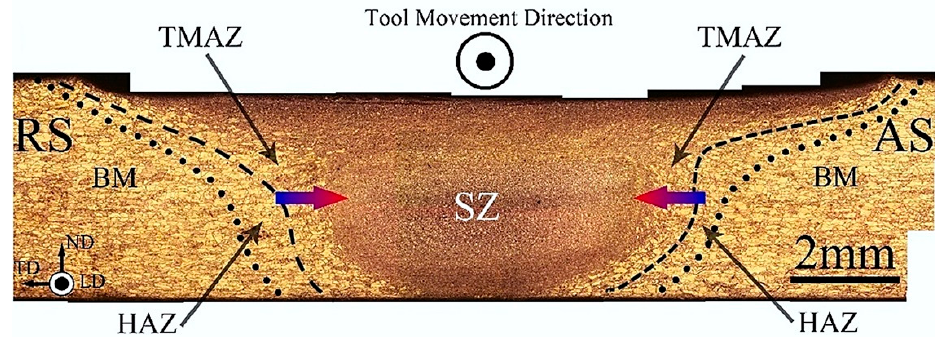
Figure 2. A common cross-section of FSWed joints that shows SZ, TMAZ, HAZ, and BM. Dotted and dashed lines indicate the outer boundaries of TMAZ and HAZ [29]. Reprinted under the CC BY 4.0